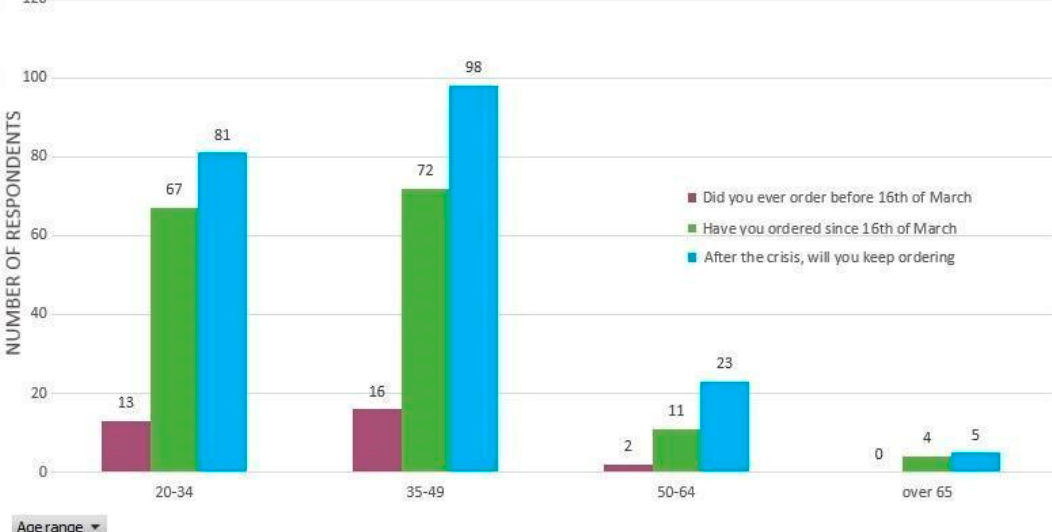
Figure 8. The number of those who declared that they bought directly delivered fresh vegetables straight from local producers before and after March 16 and who will keep buying after the COVID-19 crisis, grouped by age categories.